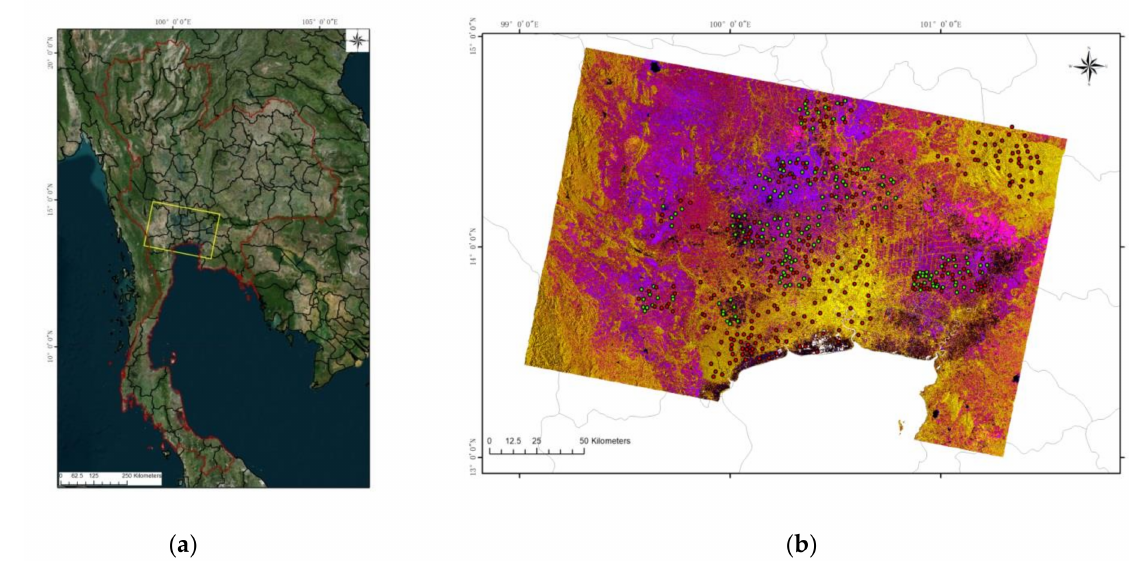
Figure 22. The experimental area used for the comparisons of different paddy rice mapping methods: ( a ) location of frame 62-4 and ( b ) false-color image of the temporal features and the distribution of validation